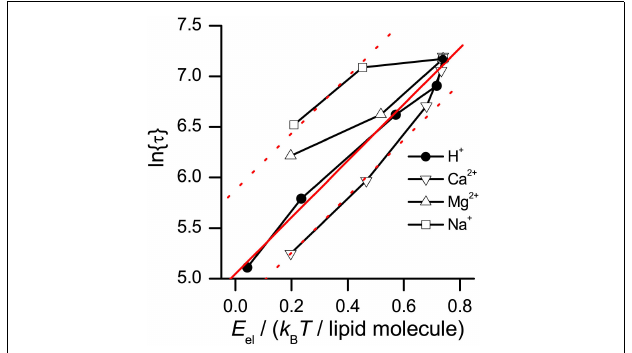
FIGURE 11 | Relation between ln{ τ } and the electrostatic free energy ( E el ) of DOPS bilayers. E el was calculated as described in Supplementary Material , using results obtained by either varying the pH (results from Figure 6 ), or by varying the concentration of Ca 2 + , Na + , or Mg 2 + in aqueous solution, at pH 7 (results from Lundbæk et al., 1997). Solid red line: Linear fit to results obtained using H + . Dotted red lines: Linear fit to results obtained using H + , shifted vertically to best match results obtained with Ca 2 + or Na +